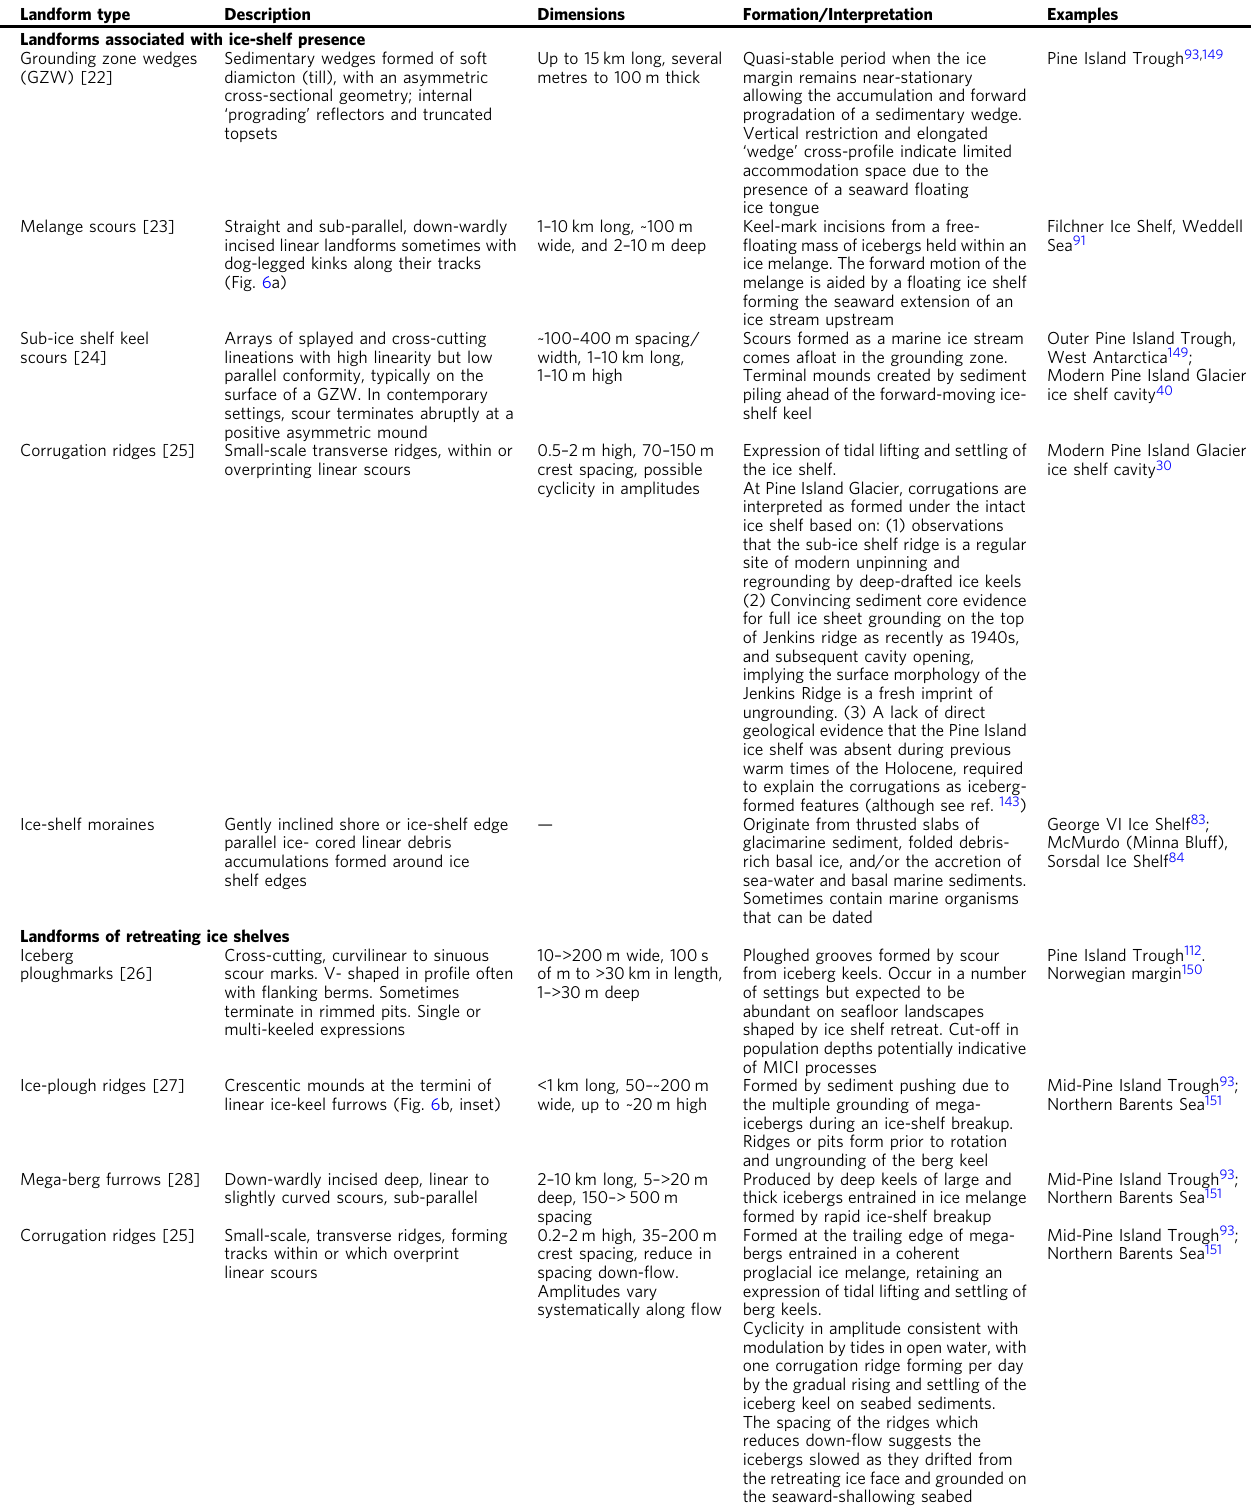
Table 1 Summary of geomorphological features associated with ice shelf presence and absence 30,83,84,91,93,112,149 – 151